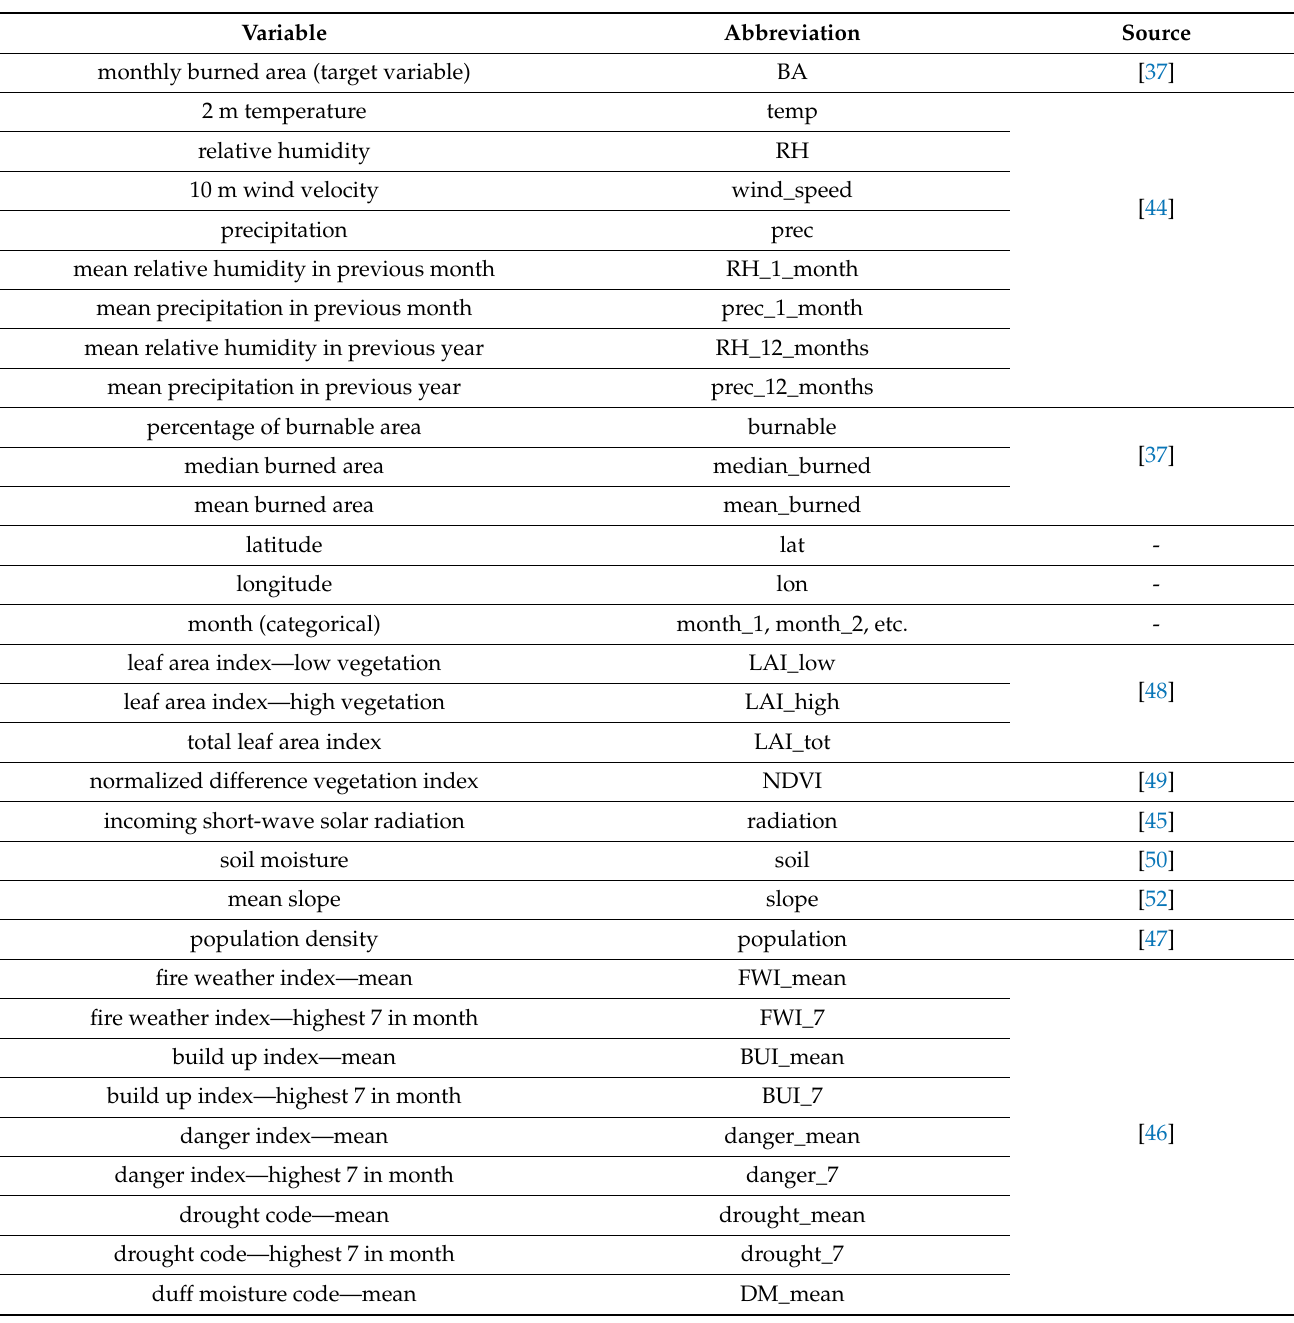
Table 1. Summary of data